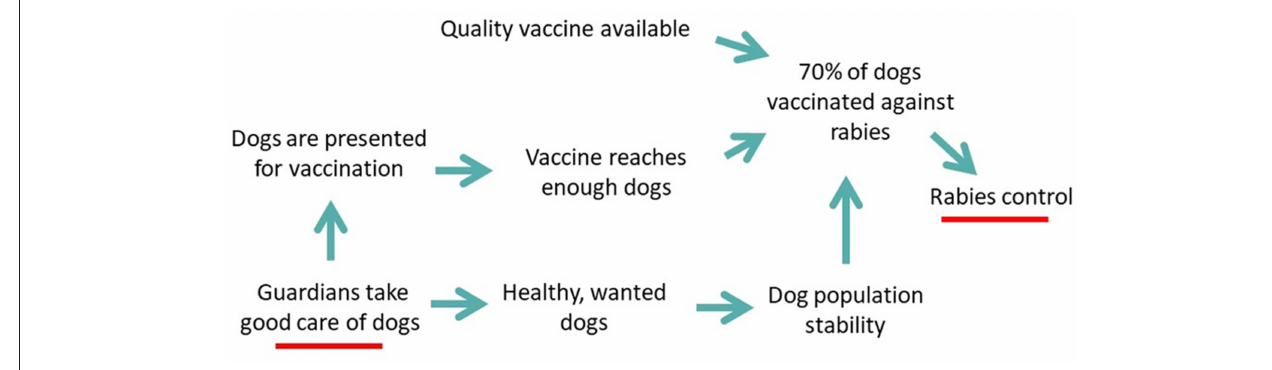
FIGURE 1 | Illustration of the theory of change for Program Dharma contribution to rabies control via improvement in dog care practices.